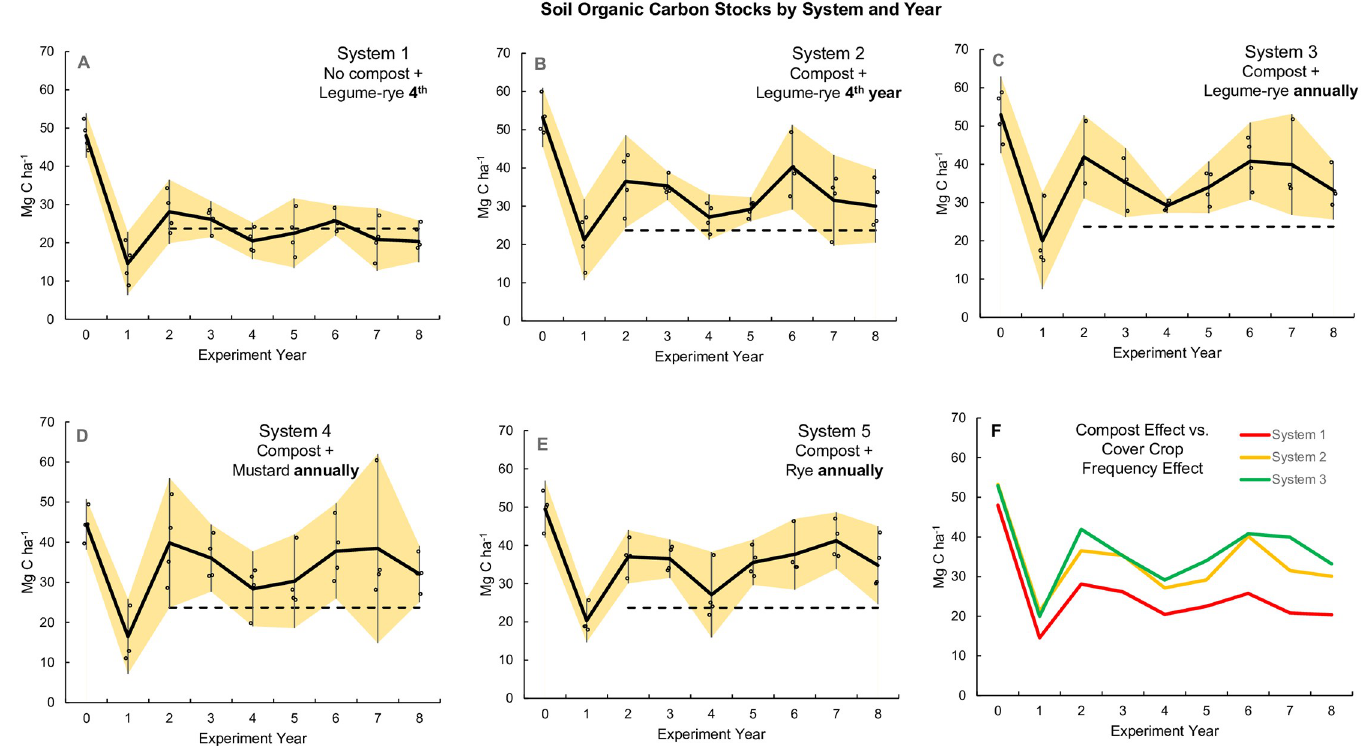
Fig 5. Soil organic carbon stocks by system and year. Measurements were taken at the 0 to 30 cm depth over 8 years in five organic vegetable systems in Salinas, CA. Systems differed by annual compost additions (0 vs. 7.6 Mg ha -1 before each vegetable crop), cover crop type (legume-rye, mustard, or cereal rye alone) and cover cropping frequency (quadrennially vs. annually planted). The dashed line indicates mean soil organic carbon between years 2 to 8 for System 1 and is included on each graph as a reference. Error bars are 95% confidence limits that are connected from year to year by the yellow band. Individual data points for reps 1 through 4 of each system are clustered around the mean.